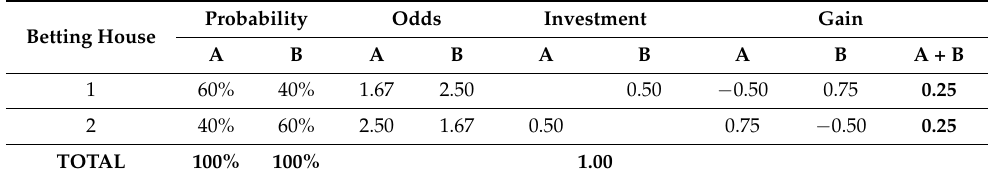
Table 5. Hedging between broker’s